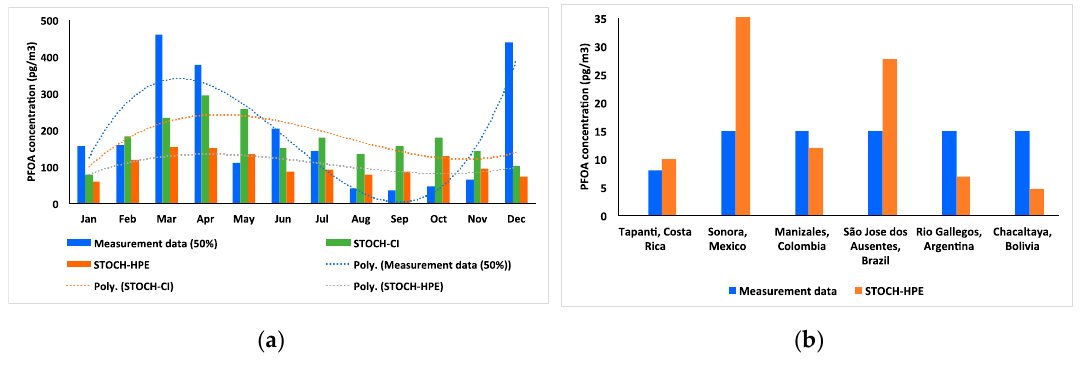
Figure 3. ( a ) A histogram showing a comparison between the measurement data collected by Harada et. al. [55] (reduced to 50% to account for the pollution of the measured environment) and model outputs for the “STOCH-CI” and “STOCH-HPE” simulations. Third -order polynomial trend lines have been imposed on each dataset to allow for an arbitrary comparison of seasonality. ( b ) A histogram showing a comparison between the measurement data collected from Rauert et al. [56] and model outputs for the “STOCH-HPE” simulation. For all sites, excluding Costa Rica, PFOA was not detected above the method detection limit (15 pg m − 3